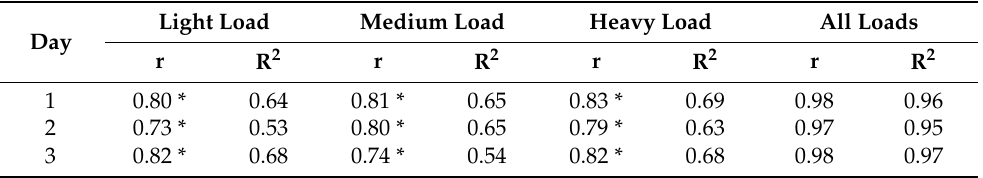
Table 4. Pearson correlation coefficients (r) and coefficient of determination (R 2 ) between mean perceived velocity (Vp) vs. mean real velocity (Vr).